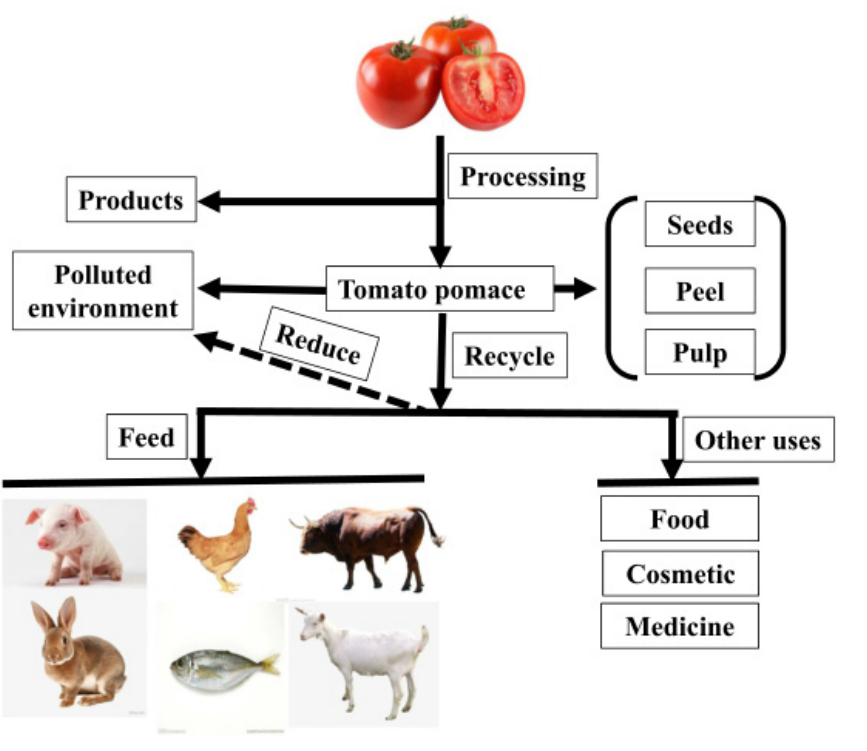
Figure 1. The processing and uses of TP.